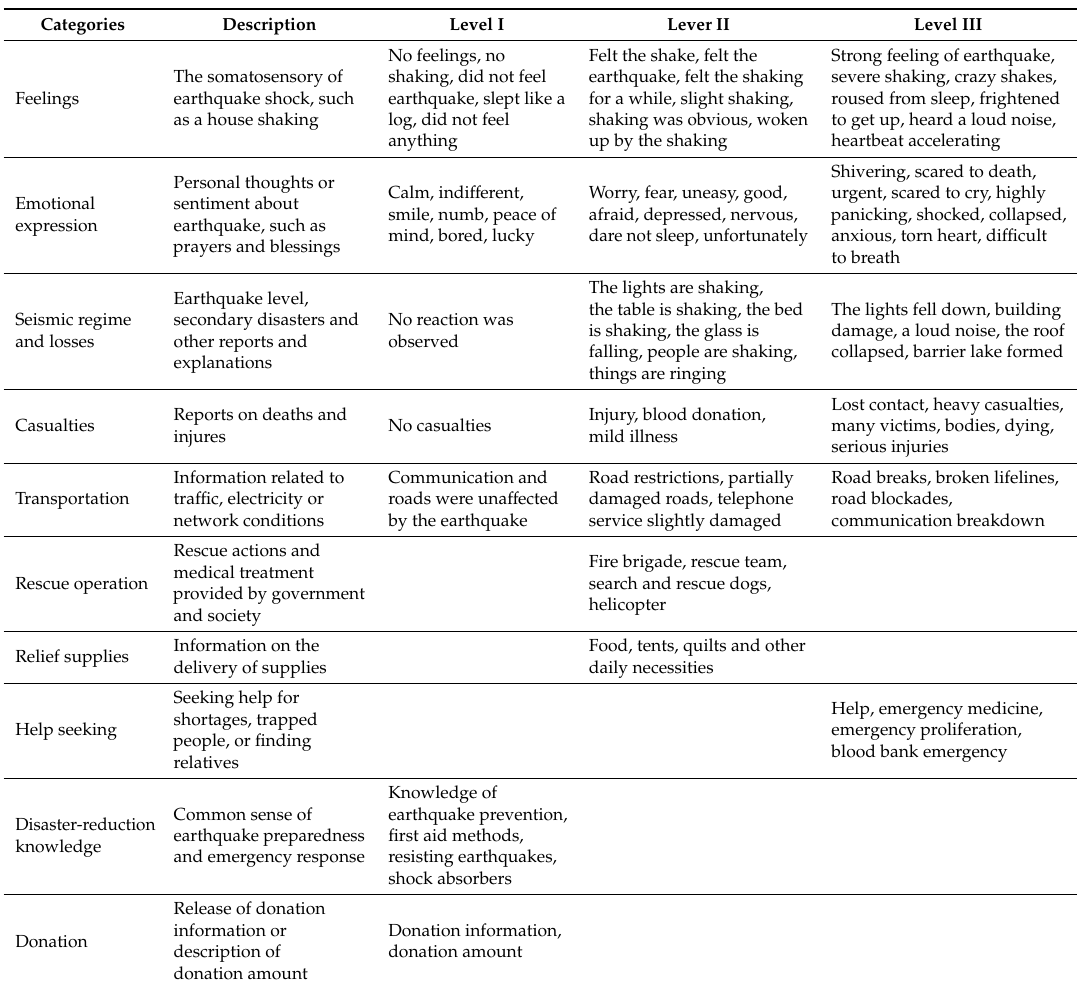
Table 1. Text urgency grading and classification